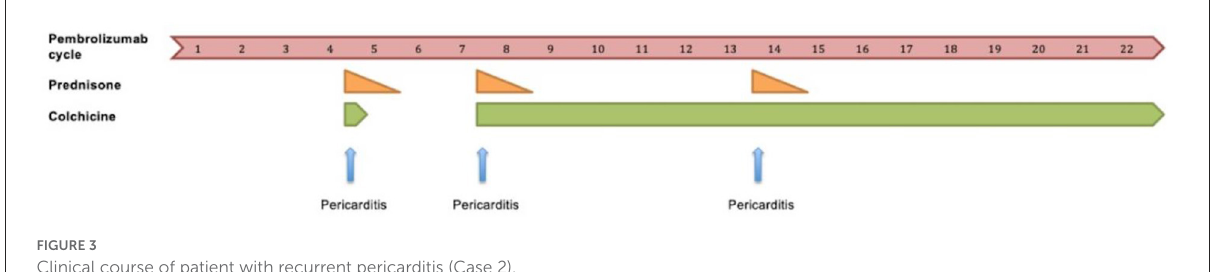
FIGURE3 Clinical course of patient with recurrent pericarditis (Case